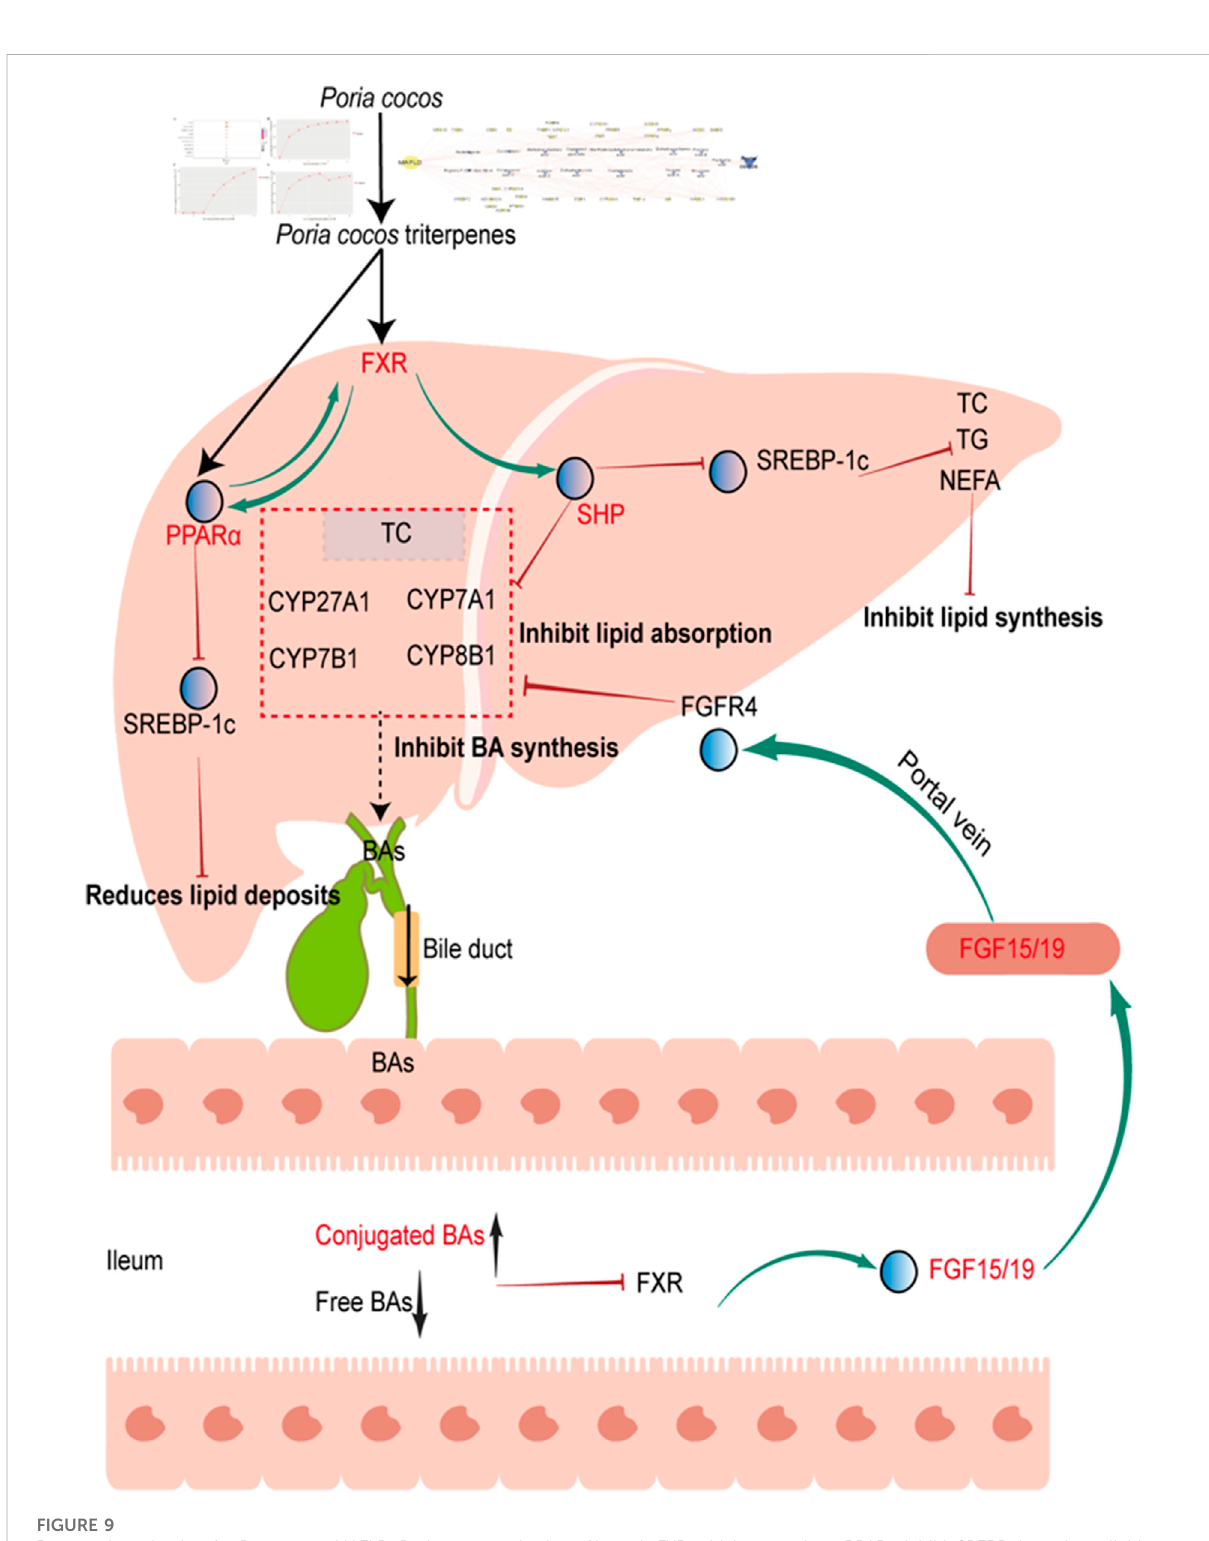
Proposed mechanism for P. cocos on MAFLD. Poria cocos activation of hepatic FXR, which can activate PPAR α , inhibit SREBP-1c, reduces lipid deposits. Activation of hepatic FXR, which can activate SHP, inhibit SREBP-1c, reduce TC, TG, NEFA levels and inhibit lipid synthesis. Activation of hepatic FXR, which can activate SHP, reduce CYP7A1 expression and inhibit BA synthesis and lipid absorption; In addition, decreased free bile acids and increased bound bile acids in the intestine can inhibit FXR expression, promote FGF15/19 expression, and reduced bile acid absorption by binding to FGFR4 and inhibiting CYP7A1 expression. FGF15/19, fi broblast growth factor FGF15/19. FGFR4, fi broblast growth factor receptor